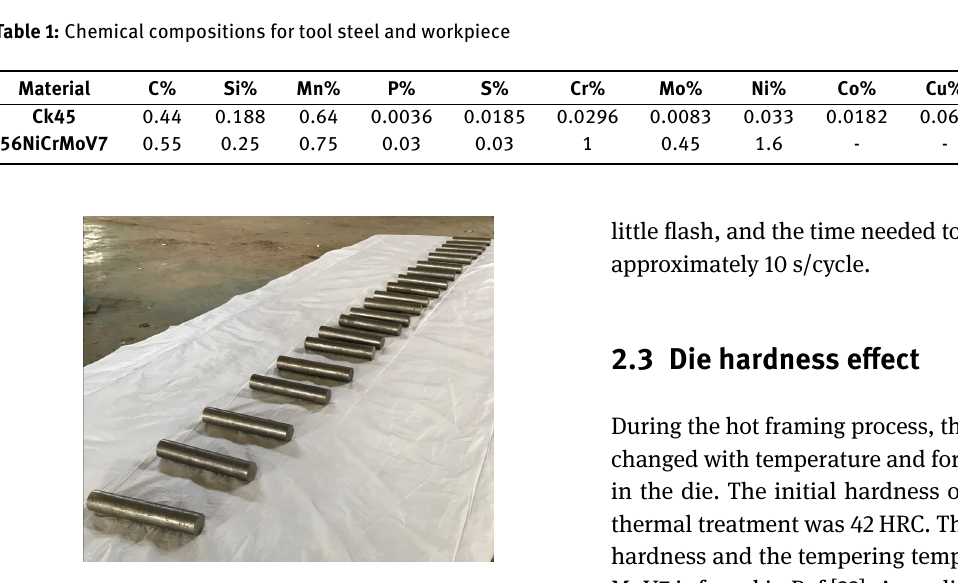
strength and resistance and heat-treatment dimensional stability [5]. The forging process in this experiment con- sisted of one cycle finishing stage with two dies – upper and lower – and a punch. The upper die and punch are movable, while a lower die is fixed. The forming process was carried out using a horizontal mechanical eccentric press, with a capacity of 800 tons, from the State Company for Steel Industry.